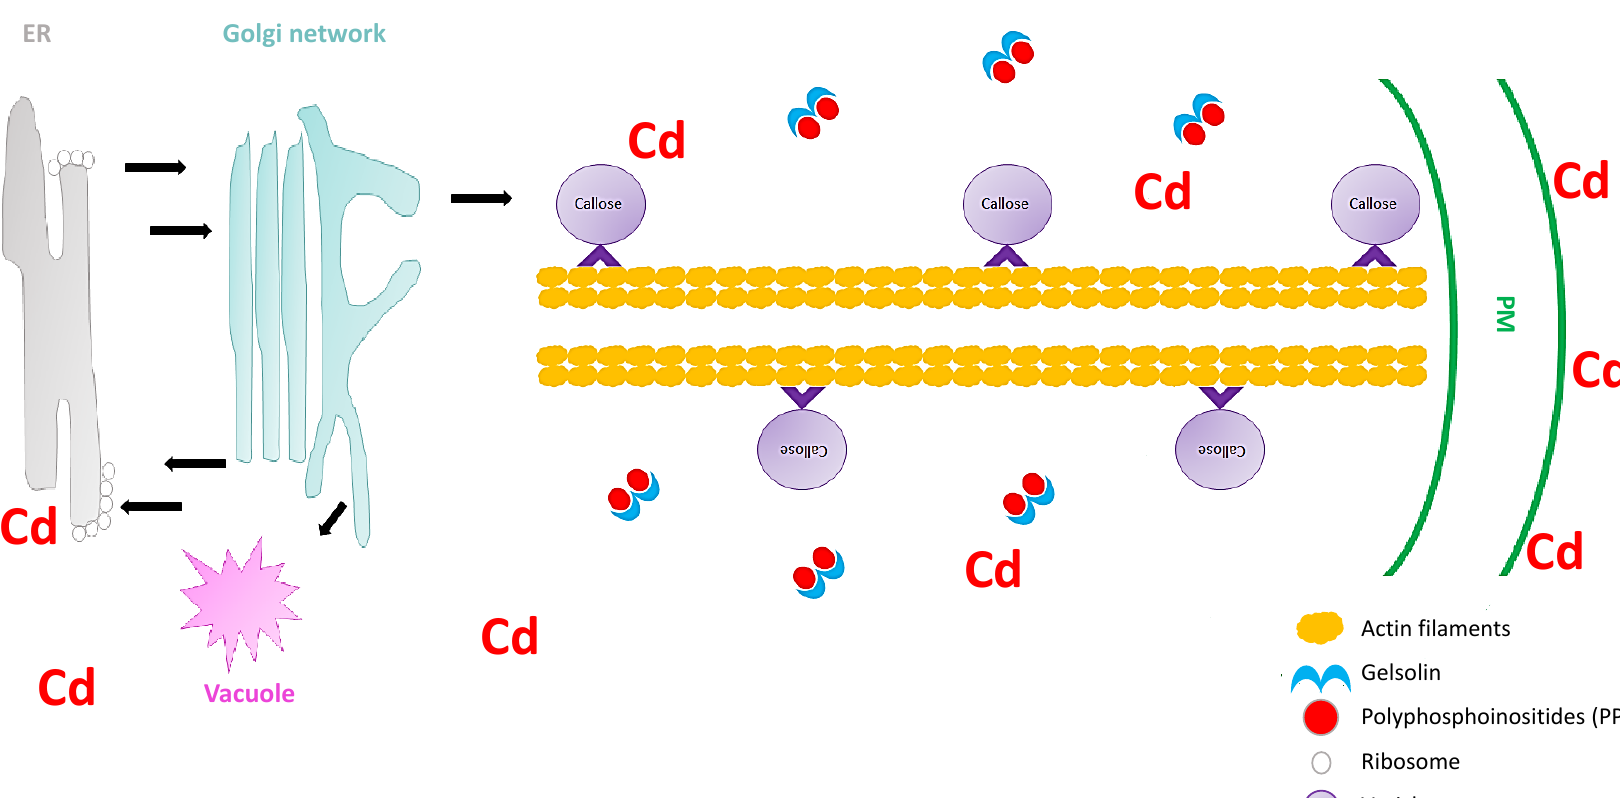
Figure 4. Representation of a future experiment, where gelsolin is inhibited by polyphosphoinositides (PPI) in Arabidopsis thaliana under cadmium stress. The vesicles move (black arrow) between the endoplasmic reticulum (ER), Golgi network, vacuole, and the PM. Cadmium stress triggers a callose response, which is sorted and packaged in vesicles for unloading at the PM. The vesicles attaches to the molecular motors (ˆ), which facilitates the movement on the actin filaments. The induced PPI inhibits gelsolin, which subsequently cannot cut the actin filaments, and therefore the vesicles can reach the PM